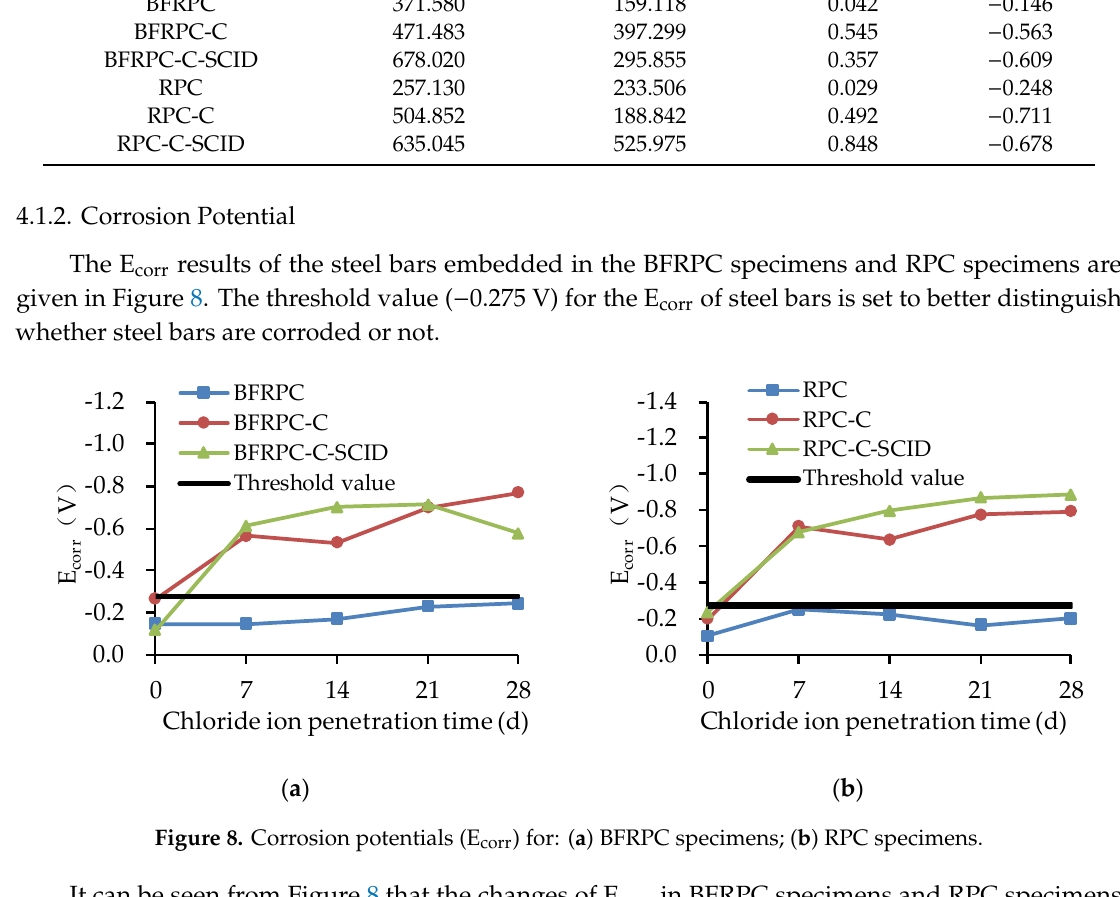
Table 4. Electrochemical parameters of the Tafel curve. Specimen Number